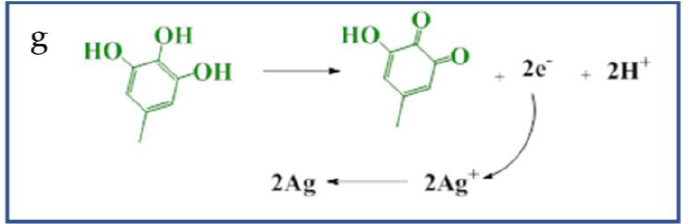
Figure 2. The effect of the melamine sponge (MS)–tannic acid (TA)–Ag substrate soaking time in TA solution ( a ), the concentration of TA solution ( b ), and the concentration of AgNO 3 solution ( c ) on the hydrophilic properties of the modified MS surface. The Fourier transform infrared spectroscopy (FT- IR) spectra of MS, MS–TA, and MS–TA–Ag ( d ). The full spectrum of MS–TA–Ag ( e ). The core-level spectrum of Ag3d regions ( f ). The production process of Ag (0) ( g ).